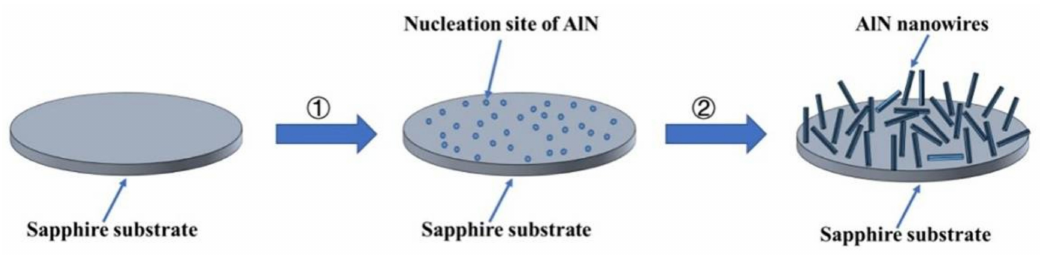
Figure 9. Schematic illustration of the growth process for AlN